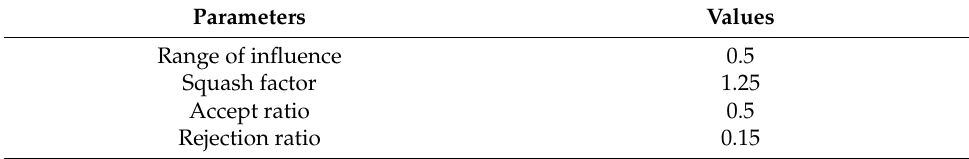
Table 9. Parameters required for SC algorithm.